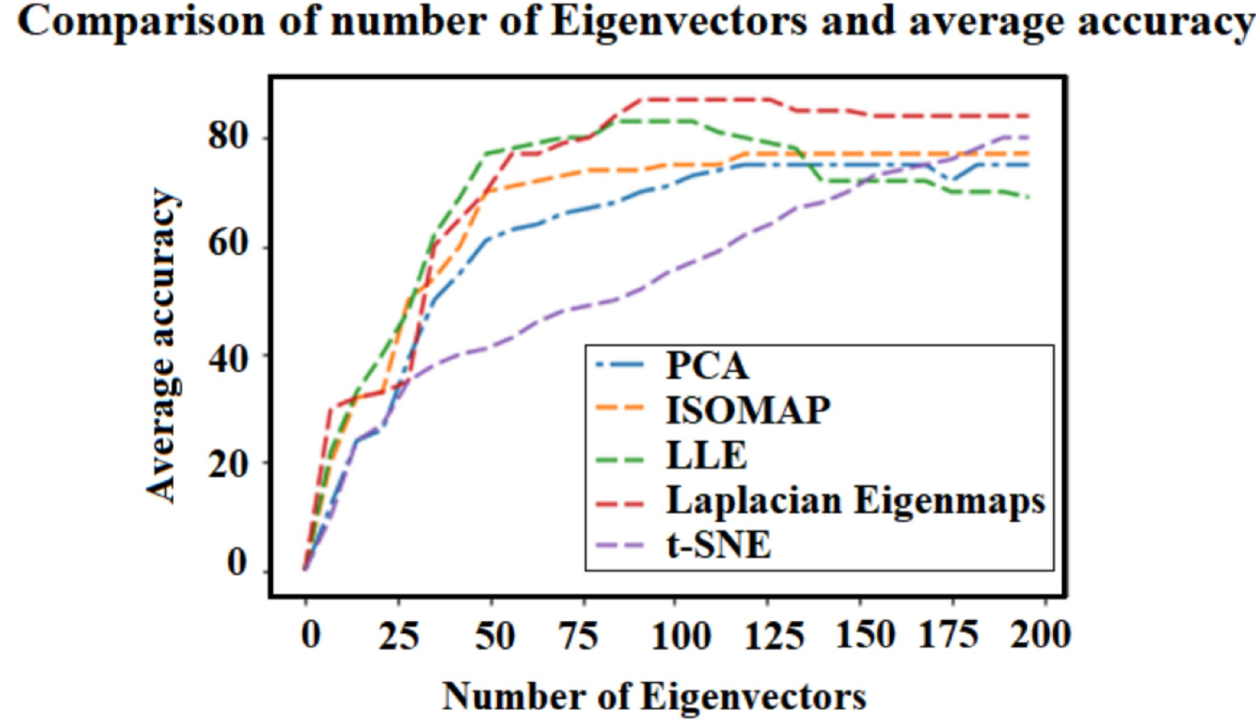
Fig 8. Average accuracy (across all 12 subject) as a function of the number of eigenvectors obtained with different dimensionality reduction techniques for the best classifier—k-NN (see also Table 3). We included PCA, ISOMAP, LLE, Laplacian Eigenmaps, and t-SNE. The LDA dimensionality-reduction technique was not included in these curves because the maximal dimension for LDA is equal to the number of classes minus one.